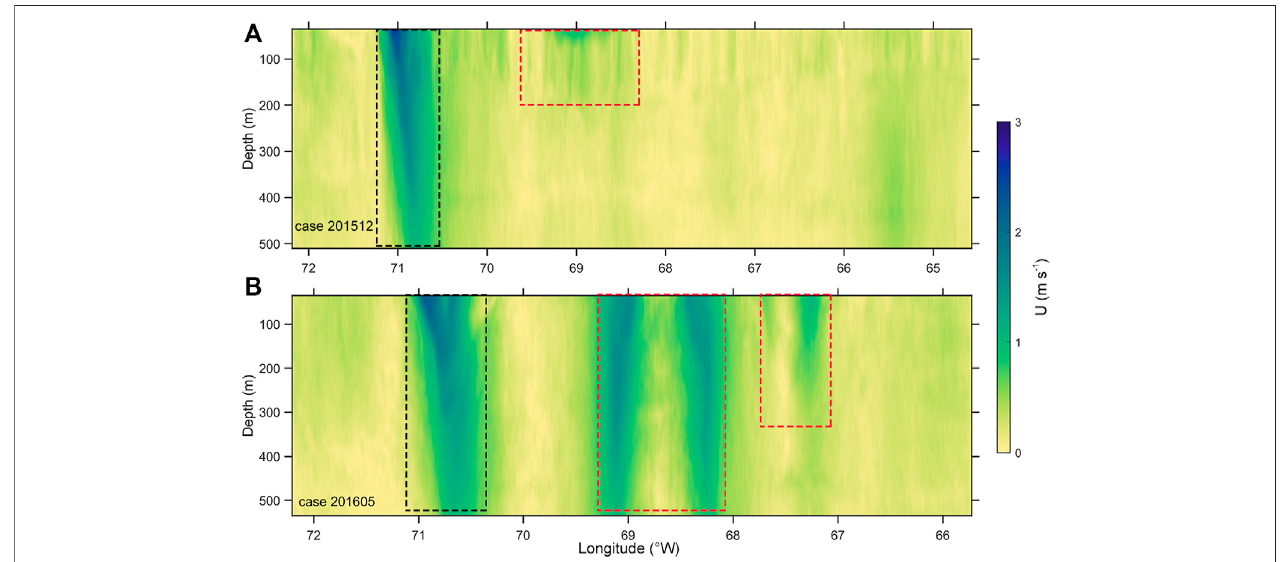
FIGURE7| Longitude – depthvariationsofvelocitymagnitudeU(ms − 1 )incase201512 (A) andcase201605 (B) .Thegraydashedlinemarksthemeanmixedlayer depth 125 m in winter. The black dashed boxes mark the Gulf Stream position, while the red dashed boxes represent the position of mesoscale eddies that generate/ in fl uence submesoscale motions.